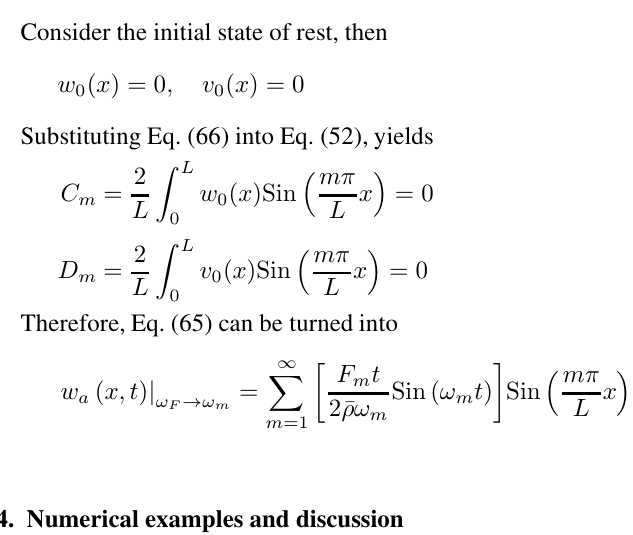
Fig. 2. Validation of the present method. Fig. 3. Variation law of the fraction of ceramic along z -axis with different k